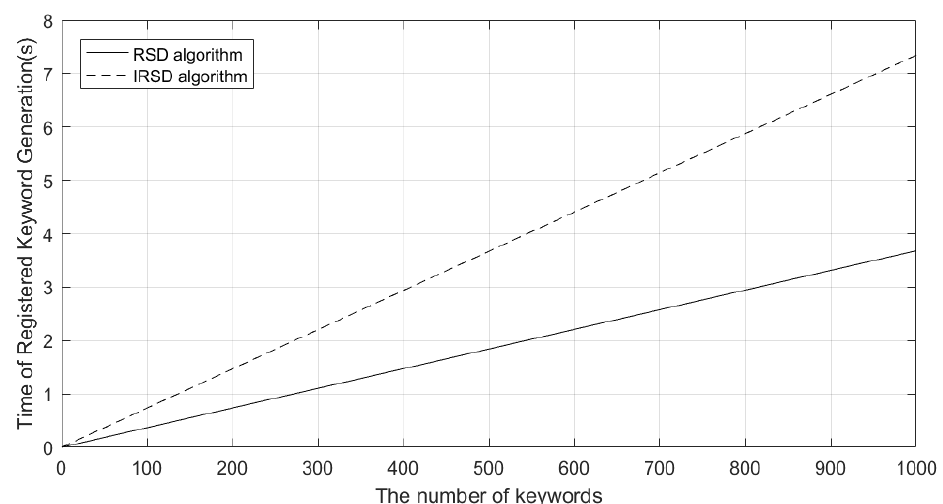
Figure 8. Comparing the time of registered keyword